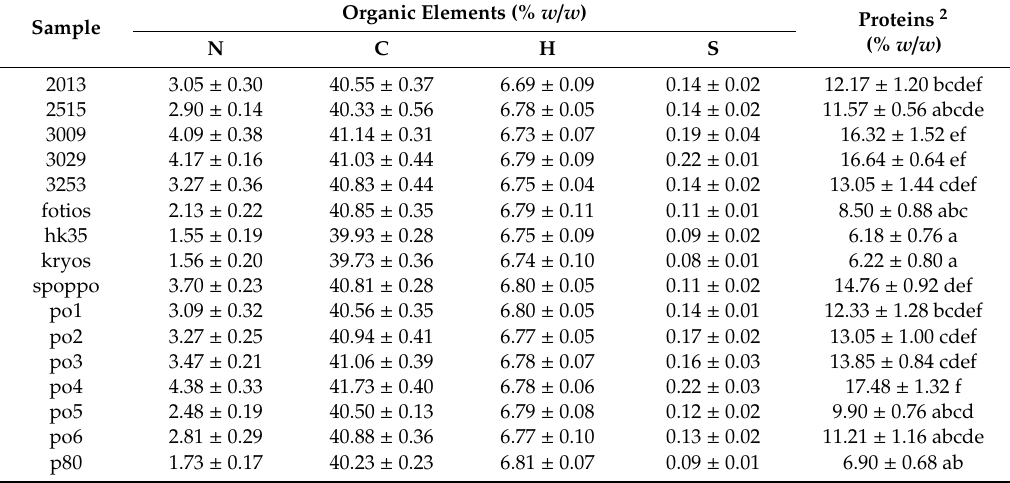
Table 2. Composition of basidiocarps: organic elements and proteins (mean ± SD) 1 .